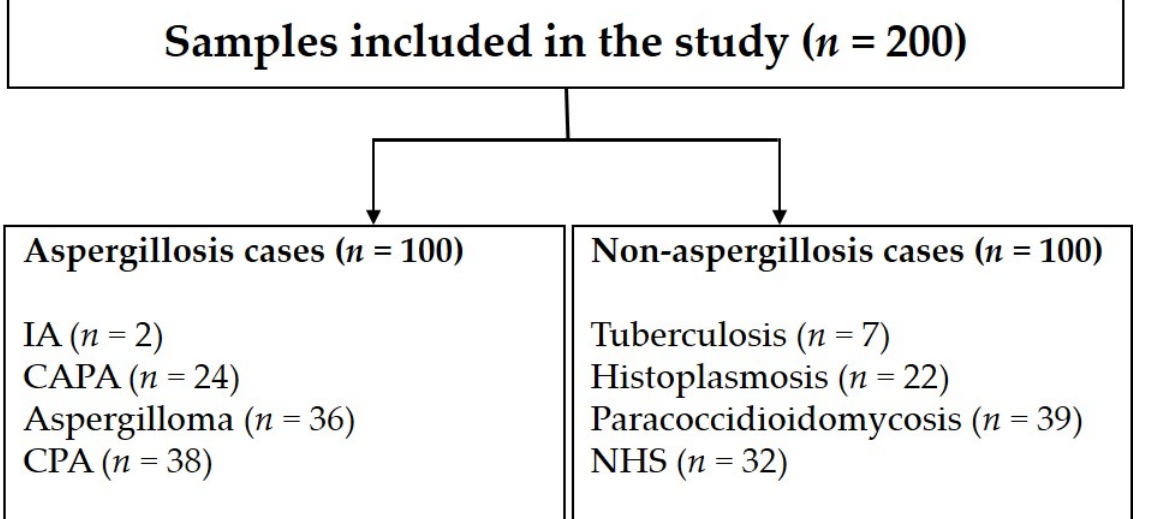
Figure 1. Flowchart representing the serum samples included in this study. In total, 200 samples were studied: 100 from patients with different aspergillosis clinical forms and 100 from individuals with other infectious diseases and healthy individuals. IA = invasive aspergillosis; CAPA = COVID- 19-associated pulmonary aspergillosis; CPA = chronic pulmonary aspergillosis; NHS = sera from healthy individuals.